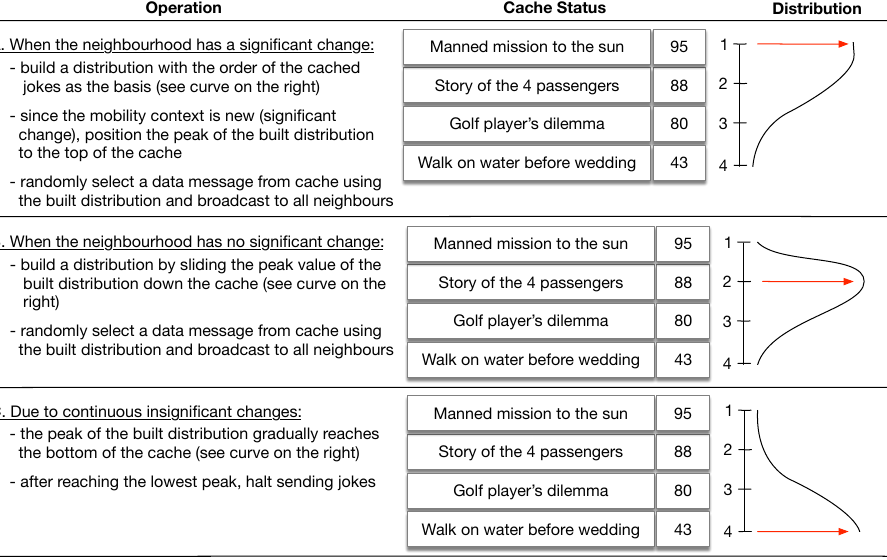
Figure A2. Message selection for forwarding mechanism of